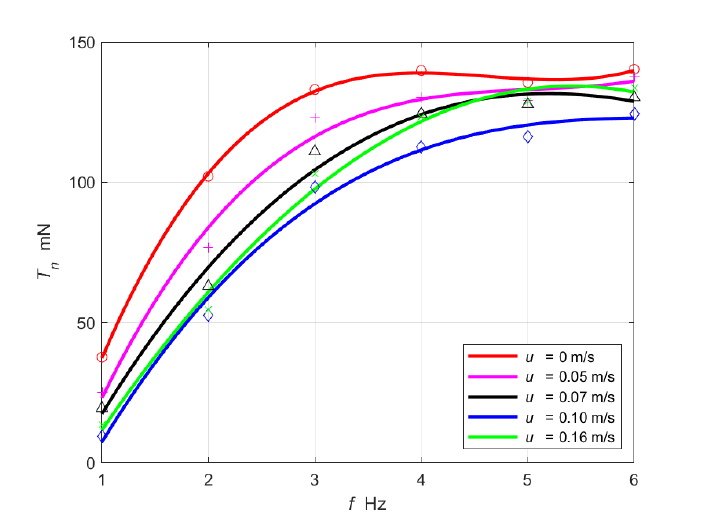
Figure 7. The mean value of the net thrust for a flexible fin made from polycarbonate.